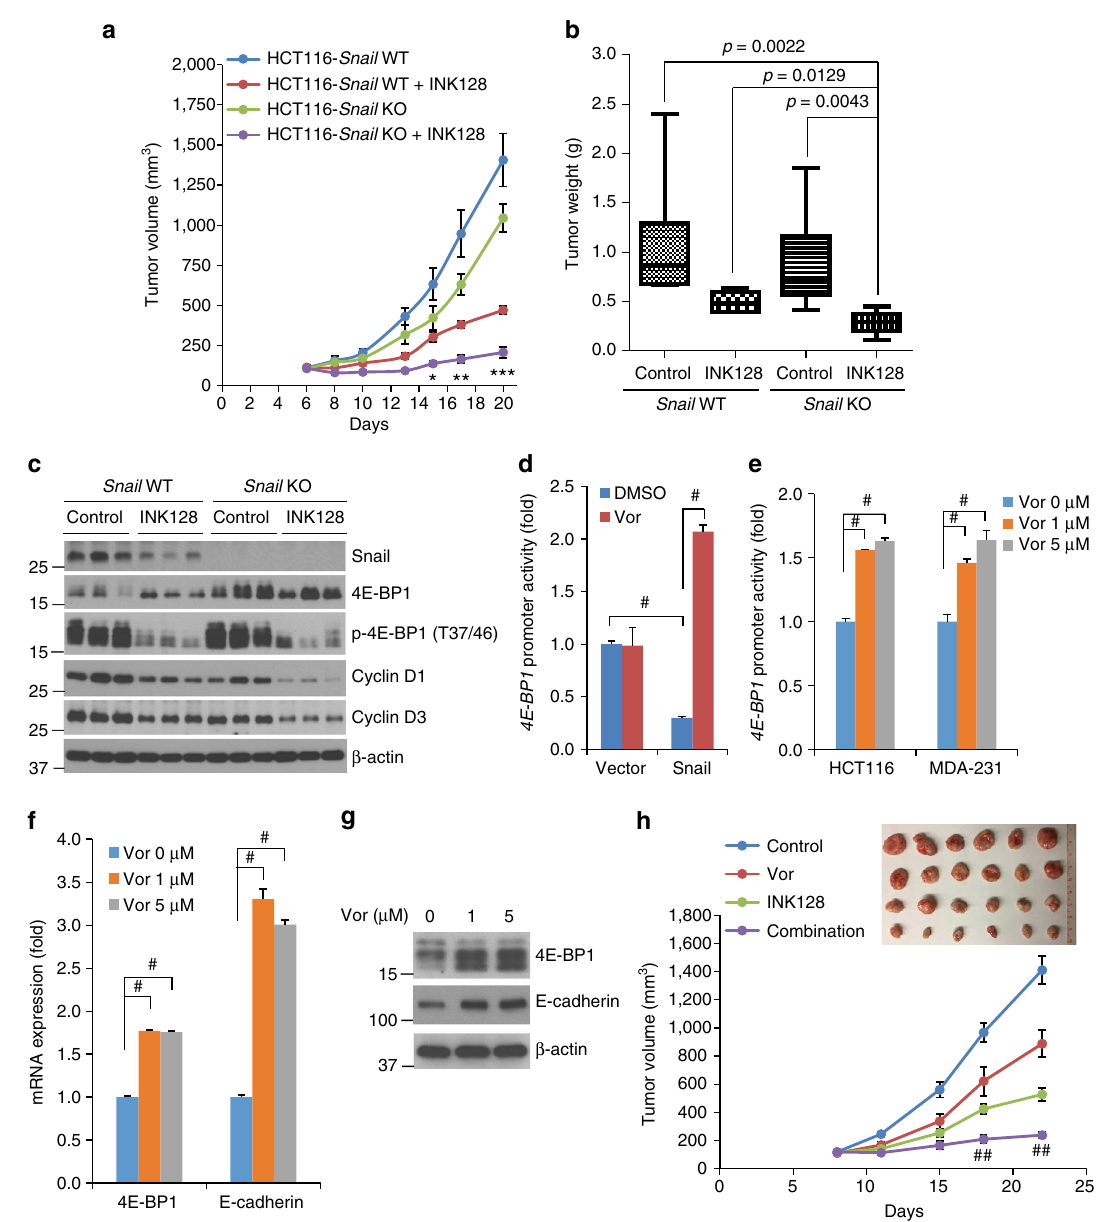
Fig. 7 Co-targeting Snail and mTOR profoundly suppresses tumor growth in vivo. a Mice bearing HCT116- Snail WT or KO xenograft tumors were treated with INK128 at 1.5 mg kg − 1 or vehicle control twice per day for 5 consecutive days each week. The results are presented as the mean tumor volume ± SEM ( n = 6 mice per group). * P < 0.02; ** P < 0.01; *** P < 0.001 for INK128-treated Snail KO vs. INK128-treated Snail WT or vehicle control-treated Snail WT or KO using Student ’ s t -test. b At the end of the experiment outlined in a , tumors were removed and weighed. The results are presented as the mean tumor weight ± SEM ( n = 6 mice/group). Statistical signi fi cance was determine by Mann – Whitney test with the p value indicated. c Representative tumors from mice treated as in a were lysed 6 h after the fi nal treatment with INK128 or vehicle control. Tumor lysates were analyzed by western blotting for the indicated proteins. d , e 4E-BP1 promoter activity was analyzed in T47D cells with stable expression of Snail or vector control d , and in HCT116 and MDA- 231 cells e that were treated with vorinostat (Vor) for 12 h. f , g HCT116 cells were treated with vorinostat for 12 h f or 24 h g , followed by quantitative RT- PCR analysis for mRNA expression of 4E-BP1 and E-cadherin relative to the levels found in DMSO-treated control cells f , or by western blot analysis for the indicated proteins g . All graphic data are presented as mean ± SEM ( n = 3 technical replicates per condition). # P < 0.001 using Student ’ s t -test. h Mice bearing HCT116 xenografts were treated with vorinostat (50 mg kg − 1 ), INK128 (1.5 mg kg − 1 ), the combination of both drugs, or vehicle control once daily for 5 consecutive days each week. The results are presented as the mean tumor volume ± SEM ( n = 6 mice per group). ## P < 0.001 for combination of vorinostat and INK128 vs. vorinostat, INK128, or control using Student ’ s t